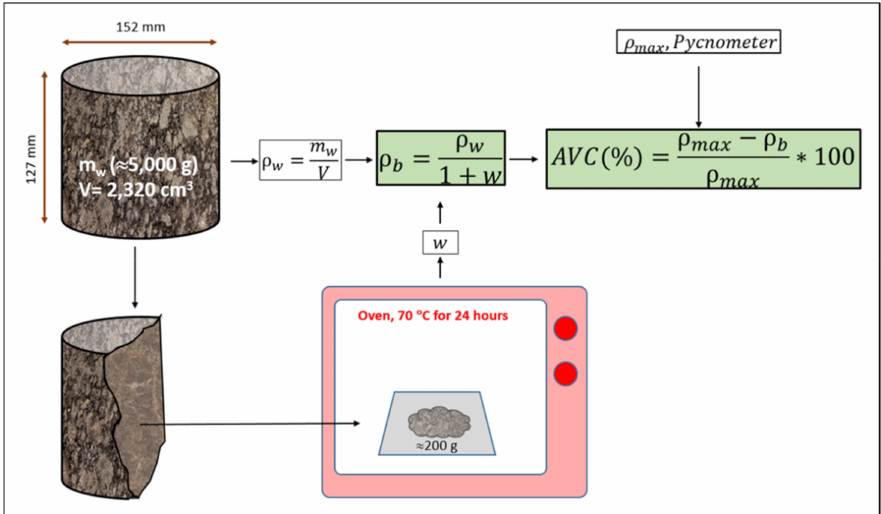
Figure 2. Scheme of the calculation of the bulk density and the air voids content for Proctor specimens.